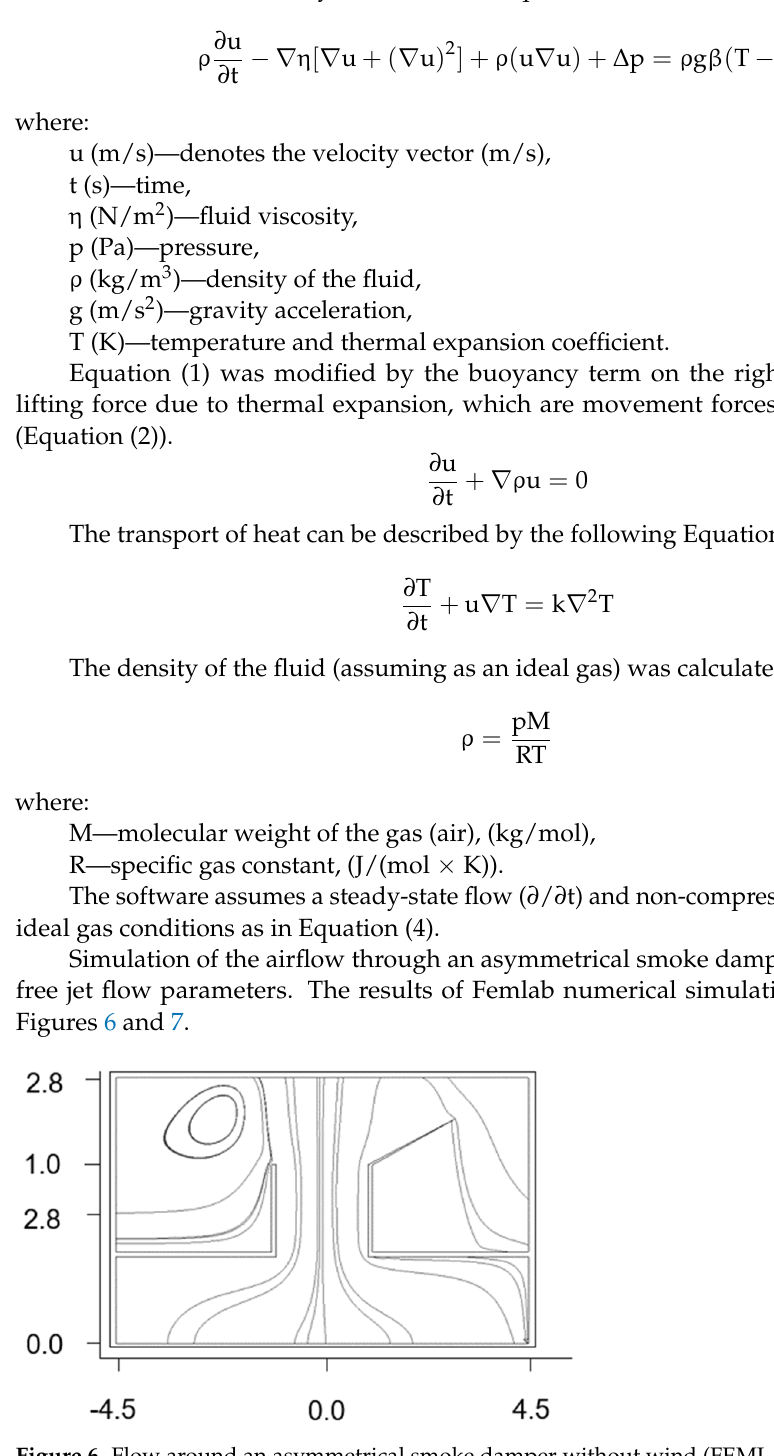
Figure 6. Flow around an asymmetrical smoke damper without wind (FEMLAB own study). On the x and y axes, the dimensions (in meters) of the staircase are shown.